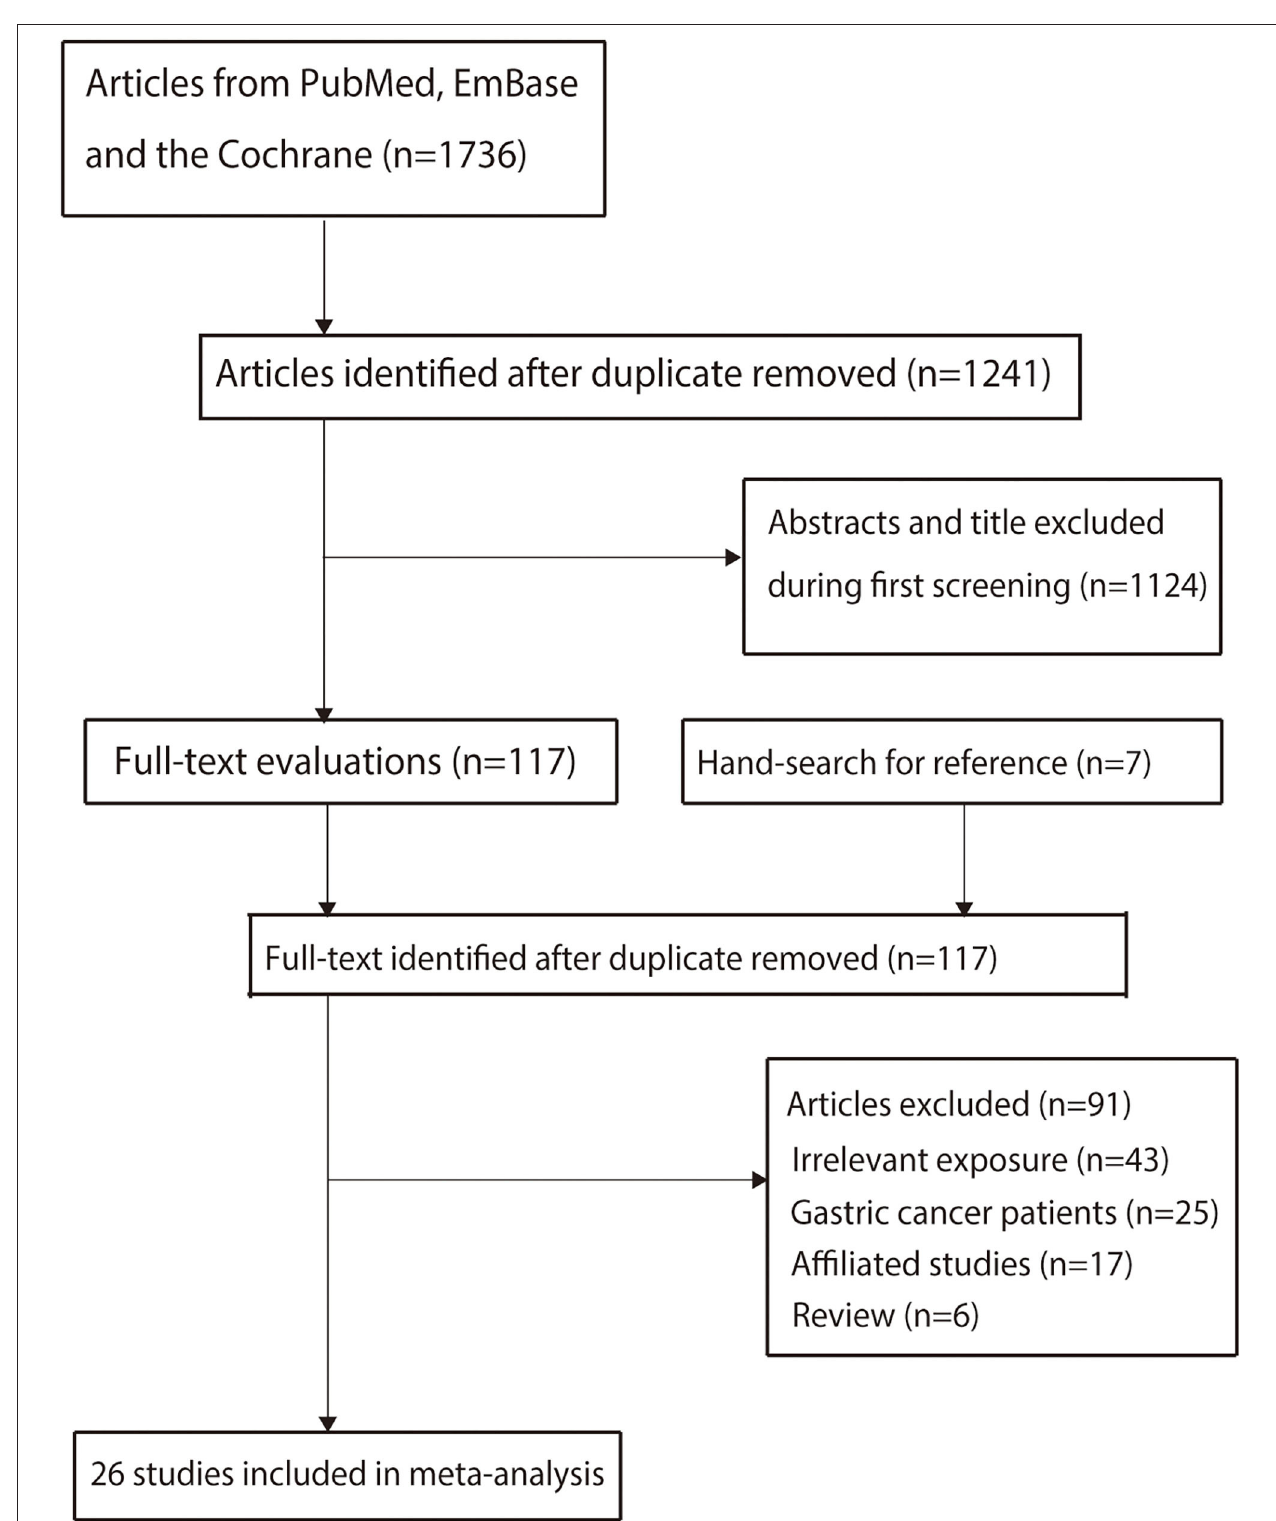
FIGURE 1 | PRISMA flowchart of the literature search and study selection process.